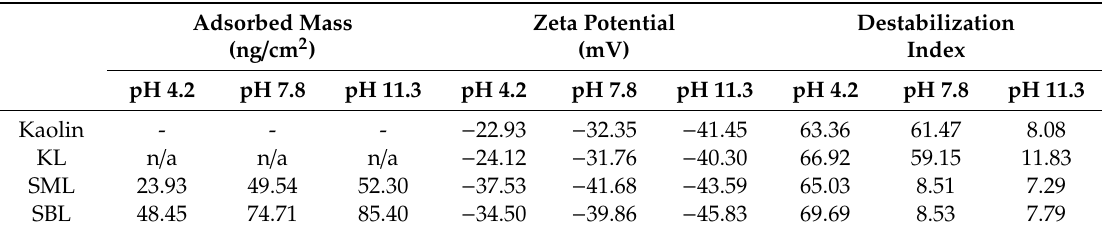
Table 3. Properties for suspensions at di ff erent pH values (500 mg / L concentration and 0.8 mg lignin / g kaolin for zeta potential and destabilization index were